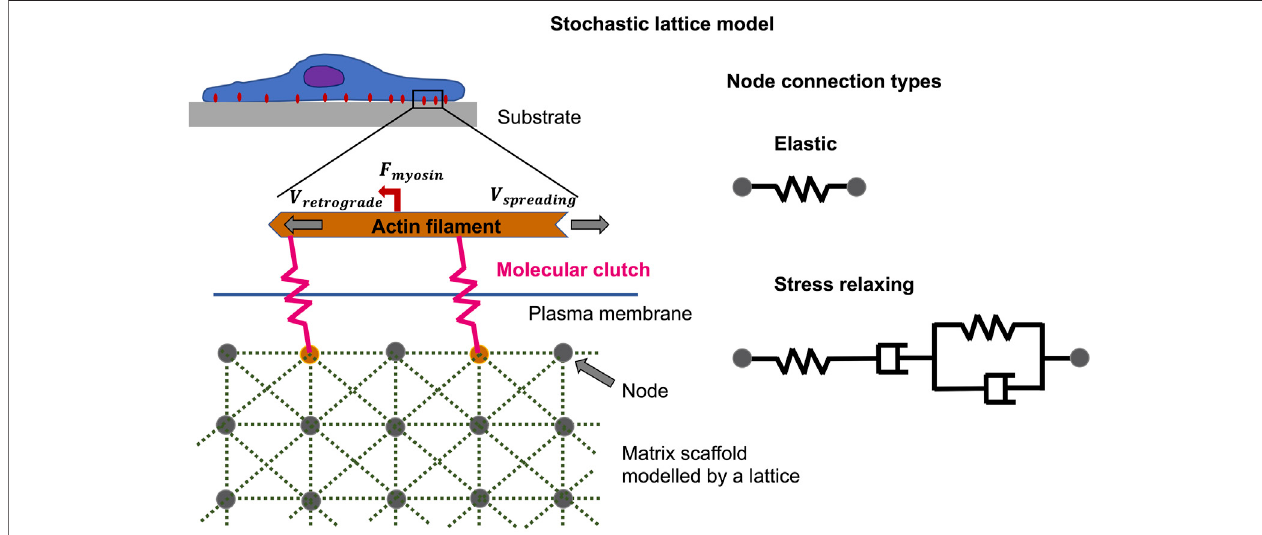
FIGURE 6 | Non-equilibrium phenomena can be described by the stochastic lattice model, such as cell spreading on elastic or viscoelastic tumor microenvironments with low stiffness. The polymerization of actin at the cell front edge is tethered to the underlying substrate by molecular clutches that impede the retrograde fl ow of myosin motors acting on actin fi laments. The elastic substrate is modelled by multiple nodes coupled by Hookean springs, whereas the viscoelastic substrate, which exhibits stress relaxation, is modelled by Burgers model elements.